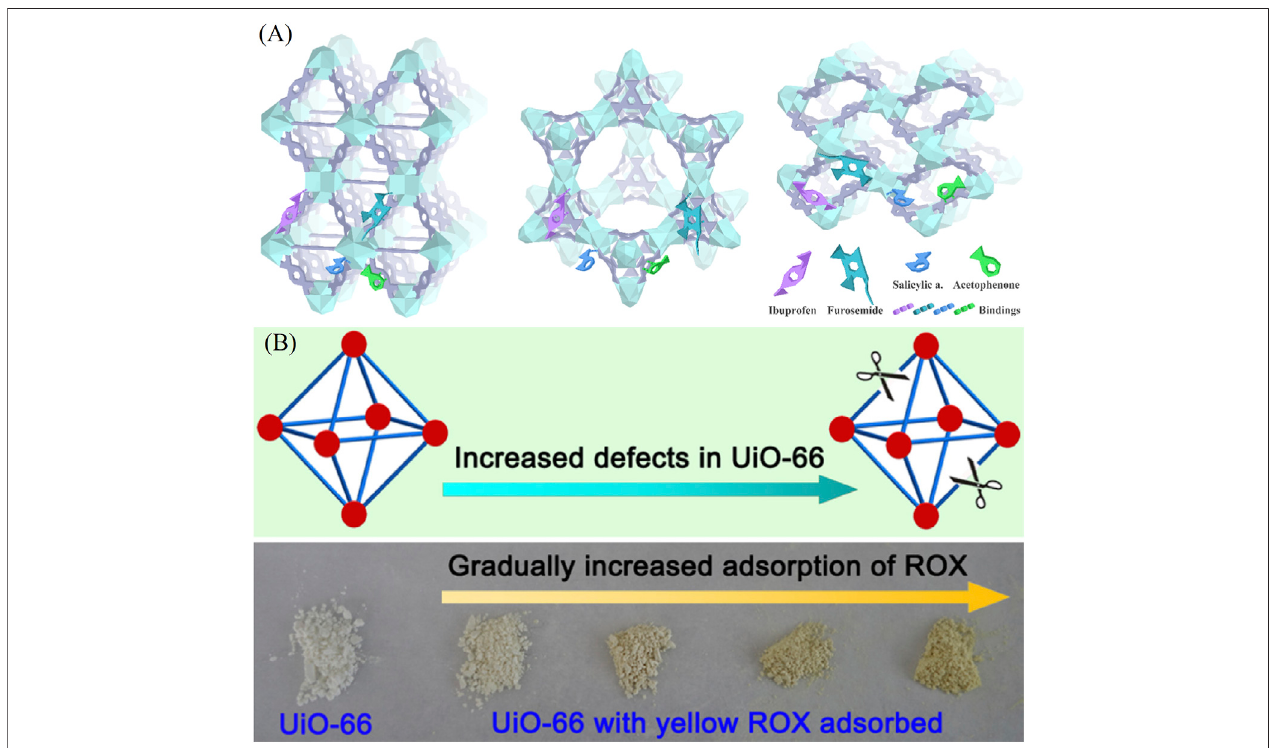
FIGURE9|(A) Schematicdiagramofinteractionsofibuprofen,furosemide,salicylicacid,andacetophenonewithZr ‒ MOFs(Linetal.,2018)and (B) defecttunable UiO ‒ 66 MOFs for ROX removal (Li et al., 2016).